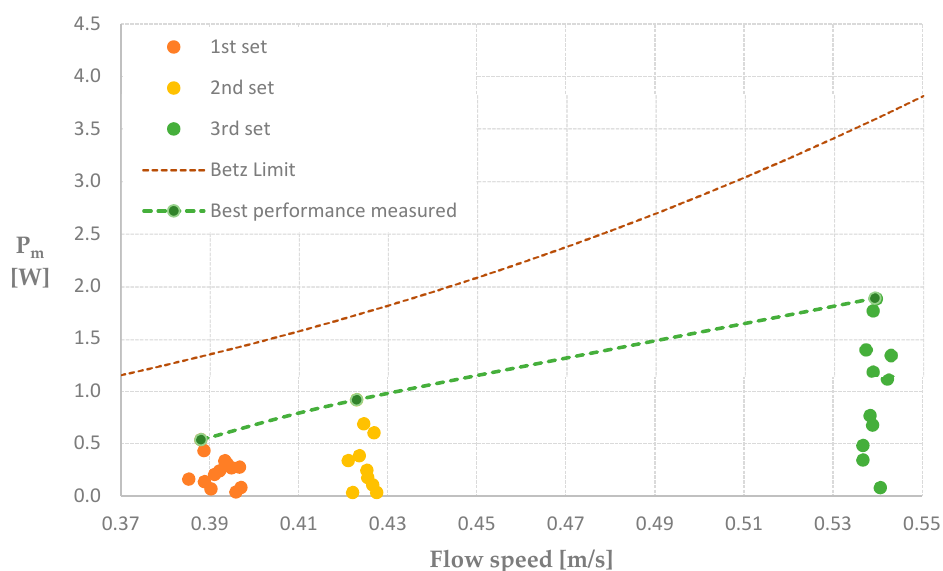
Figure 14. Mechanical power compared to Betz limit theoretical values.